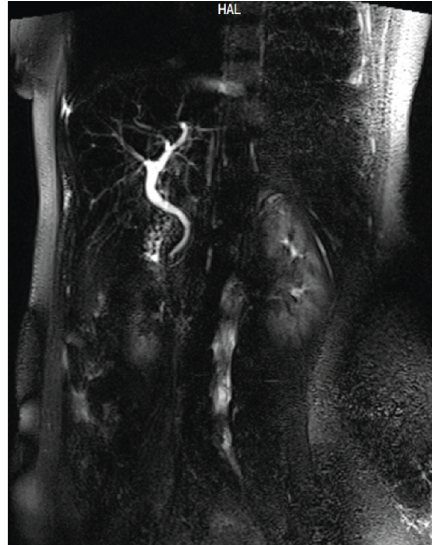
Figure 3: Magnetic resonance cholangiopancreatography during first-day postoperation, demonstrating normal intrahepatic bile ducts and slight dilation of common bile duct with an absence of gallbladder.